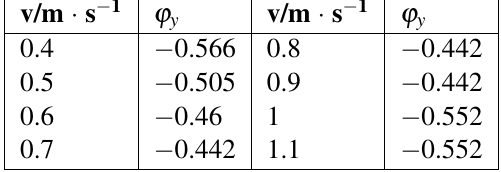
Table 5 The initial phase of the same subject at different walking speeds.